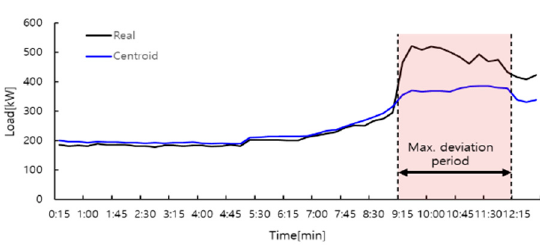
Figure 6. 22 June 2017 demand load profile.